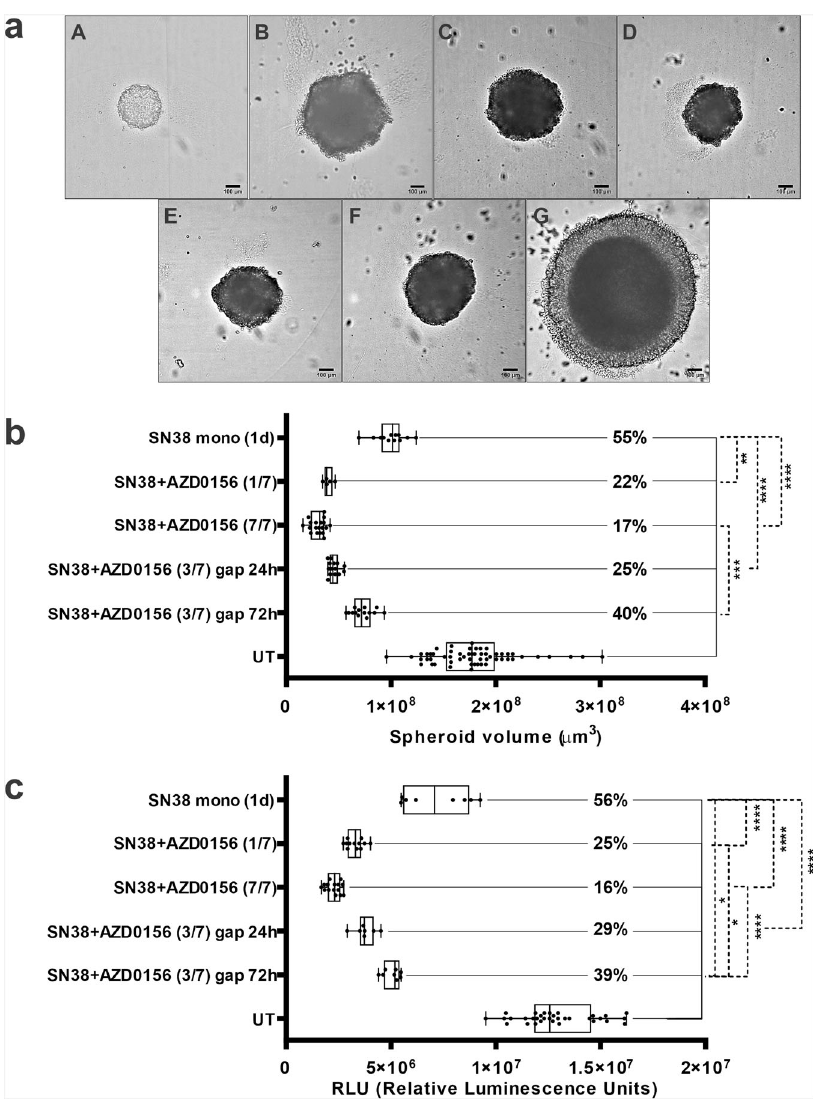
Fig. 3 SW620 tumour spheroids response at day 7 following various schedules of SN38 and AZD0156 delivered in micro fl uidic Ibidi chip. a Bright fi eld microscope images of SW620 tumour spheroids at day 0 and 7 days following different treatment schedules with SN38 and AZD0156: A Untreated day 0; B SN38 monotherapy; C SN38 + AZD0156 1/7; D SN38 + AZD0156 7/7; E SN38 + AZD0156 3/7 (24 h gap); F SN38 + AZD0156 3/7 (72 h gap); G Untreated day 7; b Spheroids were imaged in situ in the chip at day 7 and their volumes calculated from average radius deducted from min/max Feret. c Spheroids were recovered from the chip at day 7 and their viability measured by CellTiterGlo assay. n ≥ 5 per condition from two independent experiments. Box-plots show median (centre line); box limits are 25th to 75th percentile; whiskers represent min and max values. Statistical analysis using 1-way ANOVA, Tukey ’ s multiple comparisons, CI = 95%, **** p < 0.0001; *** p < 0.001; ** p < 0.01; * p <